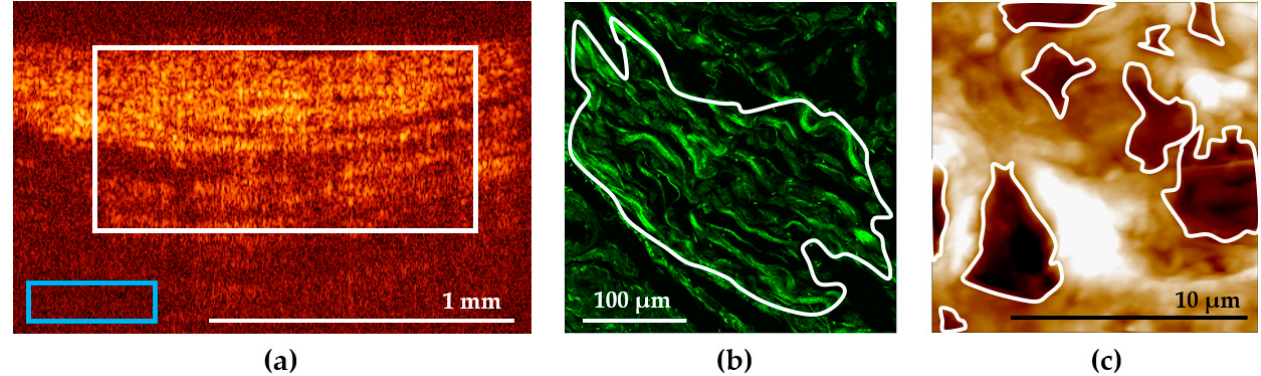
Figure 1. Examples of the ROI selection in the bladder images: ( a ) in a cross-polarization OCT image; ( b ) in an SHG image; ( c ) in an AFM image. ROI is marked with a white contour, the blue rectangle in ( a ) marks the background region selection.